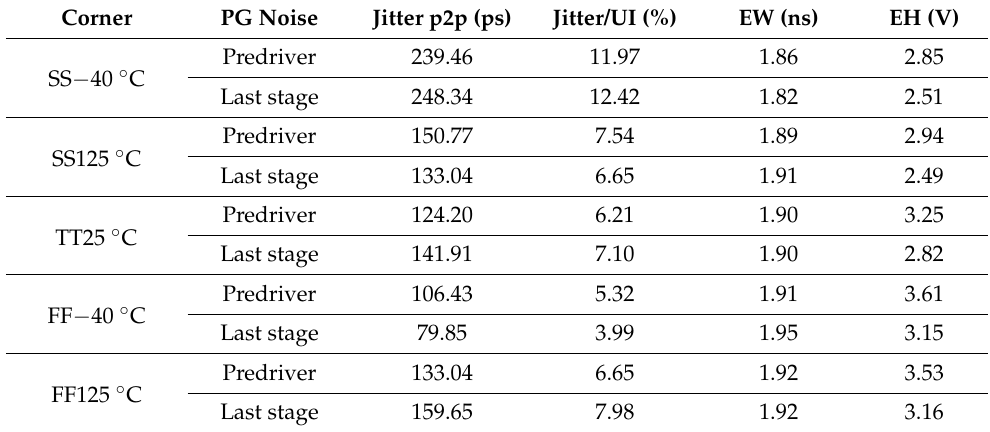
Table 3. Eye Diagram Metrics: PGSV Noise Sources are Considered at the Pre-driver or Last Stage. Corner PG